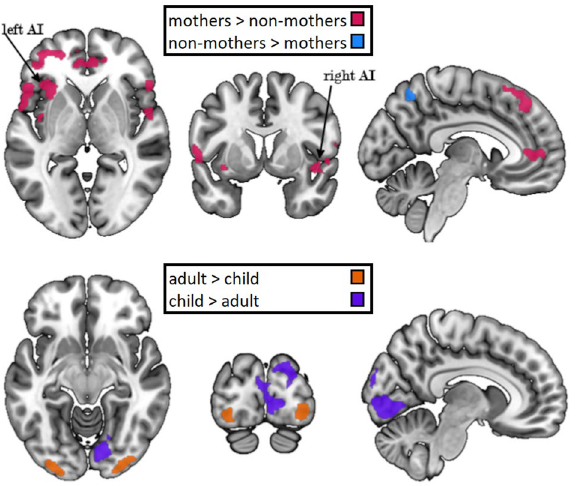
Figure 3. Results of the four main contrasts in the whole-brain analysis with a cluster corrected threshold of pFWE < 0.05. Images have been created with MRIcroGL 70